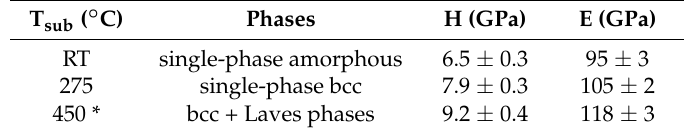
Table 1. Deposition parameters phase composition, hardness H, and Young’s modulus